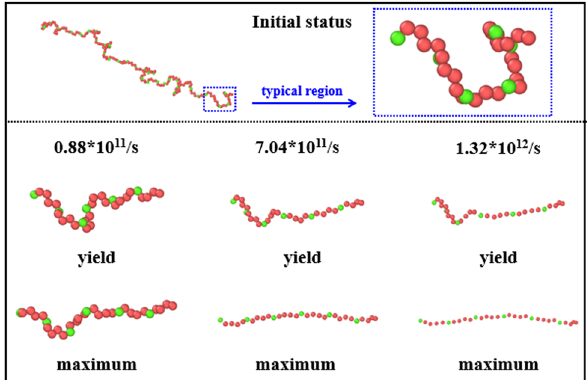
Figure 9: Zoomed - in observation on the disentanglement part, α , located at the ending part of a whole molecular chain at the initial, yield stress and maximum stress points at di ff erent strain rates of 0.88 × 10 11 , 7.04 × 10 11 and 1.32 × 10 12 /s,